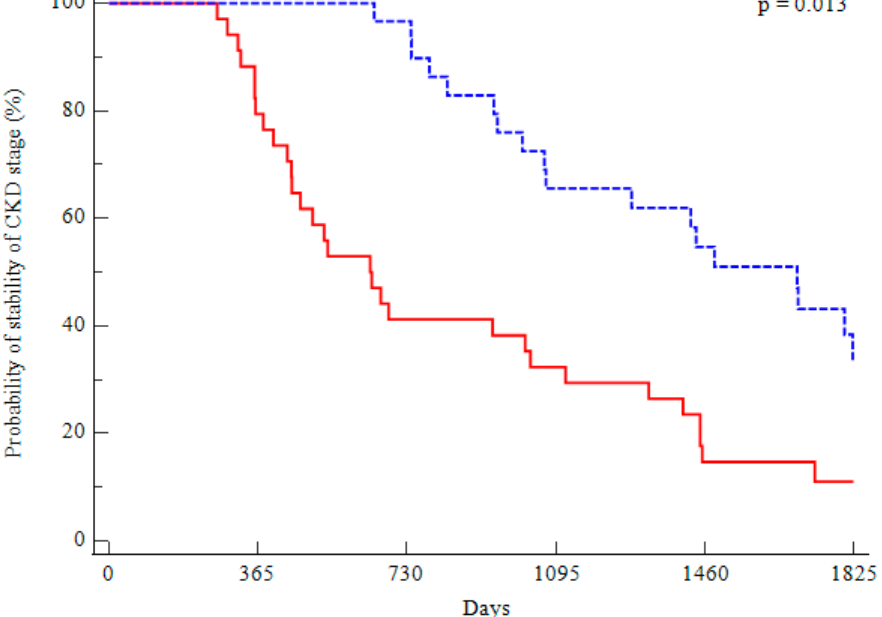
Figure 3. Kaplan-Meier curves showing the probability of changes in CKD stages in the two groups (blue, exercise; red, control).